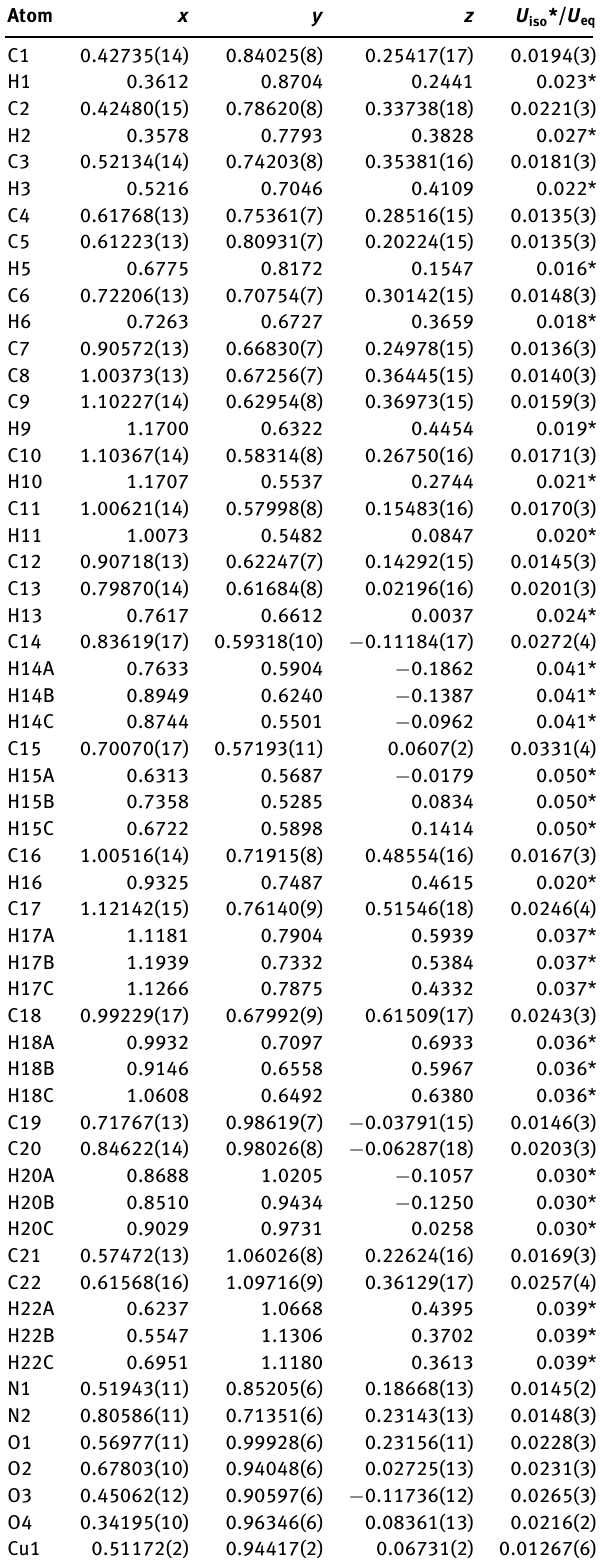
Table 2: Fractional atomic coordinates and isotropic or equivalent isotropic displacement parameters (Å 2